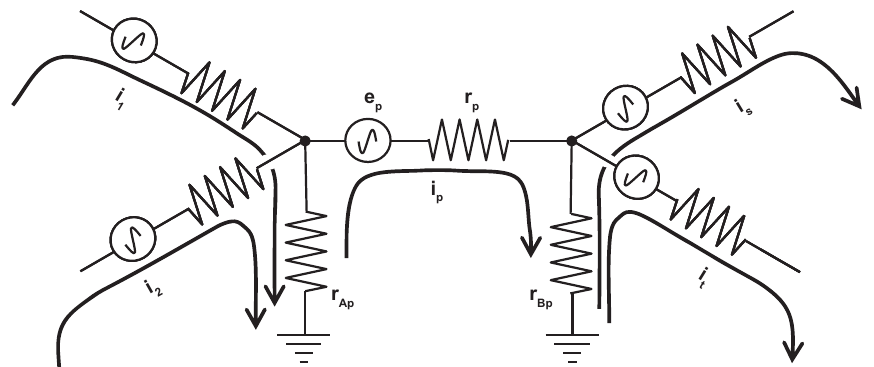
Fig. 2. Modelling GIC using the Mesh Impedance Matrix method.